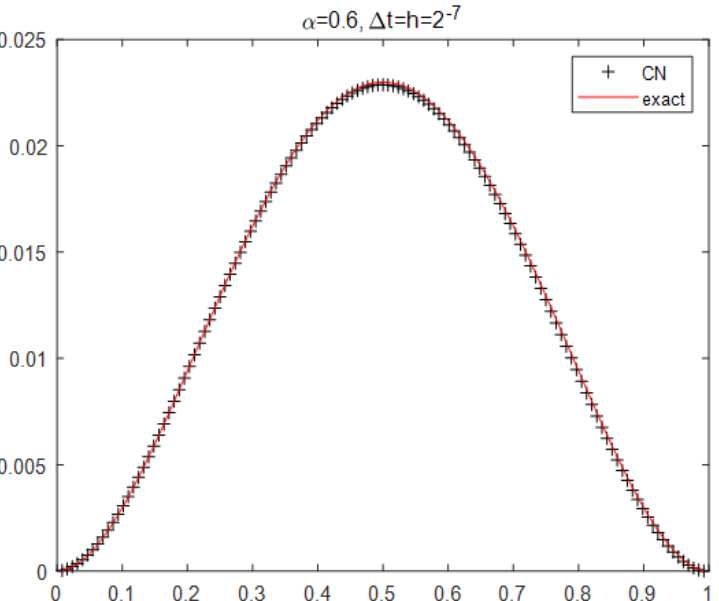
Figure 3. The numerical solution for the Crank-Nicolson scheme and exact solution for Example 1 with α = 0.6, ∆ t = h = 2 − 7 at time T = 1.